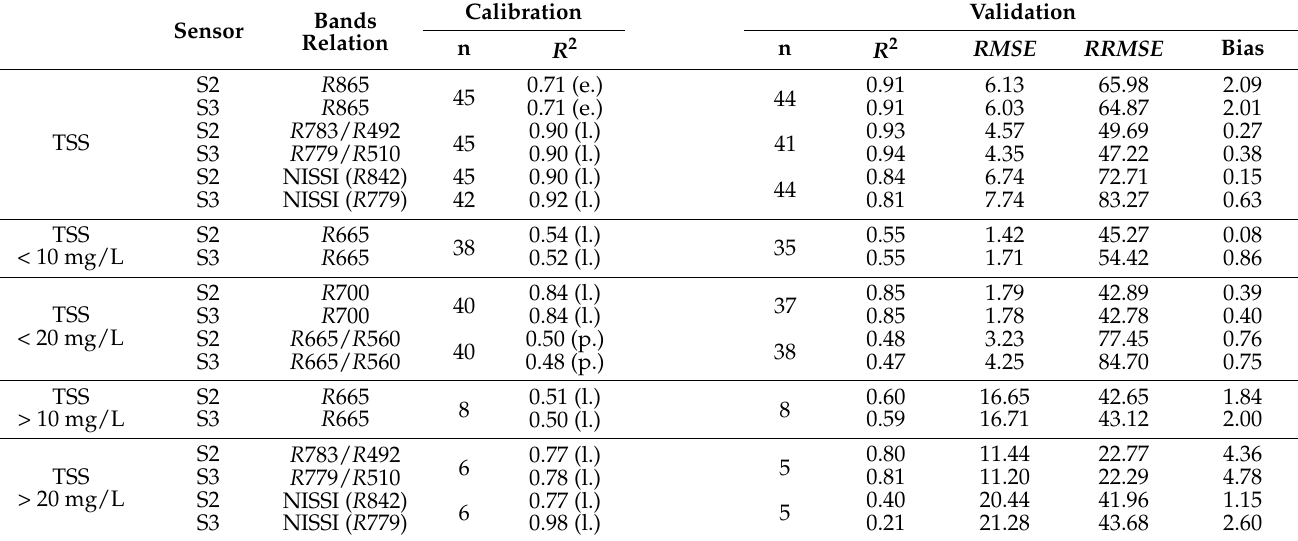
Table 7. Calibration and validation results for TSS. Only results with a calibration with R 2 > 0.4 are shown. Regressions: linear (l.); potential (p.); exponential (e.). RMSE (mg/L); RRMSE (%); bias